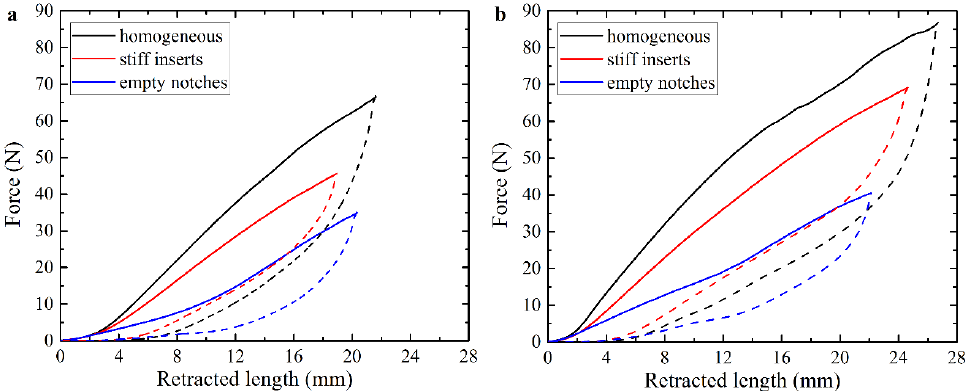
Figure 7. Force-retraction curves for the homogeneous FLX9760 actuator and actuators with empty notches and stiff inserts without external load ( a ) and with additional 150 g weight on the free end of the specimen ( b ).